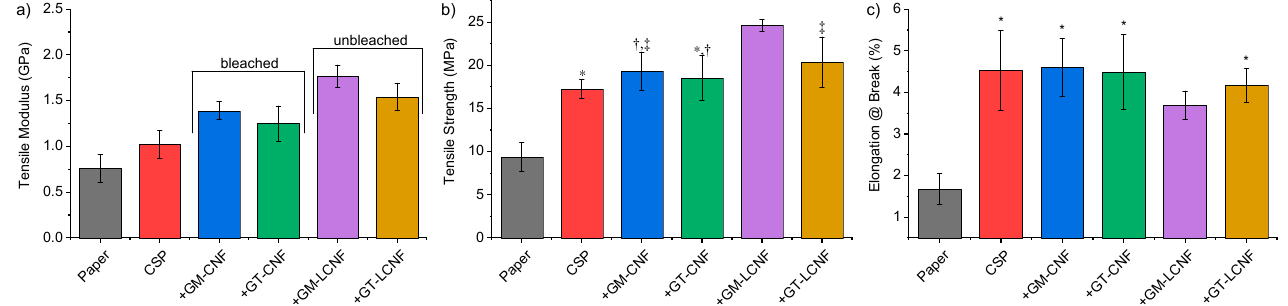
Figure 6. Stress–strain curves for various filter paper samples for control paper group and after treatment with formulations of cottonseed protein isolate (CSP) and cellulose nanofibers (CNFs) or lignin-containing cellulose nanofibers (LCNFs) from cotton gin motes (GM) or gin trash (GT).